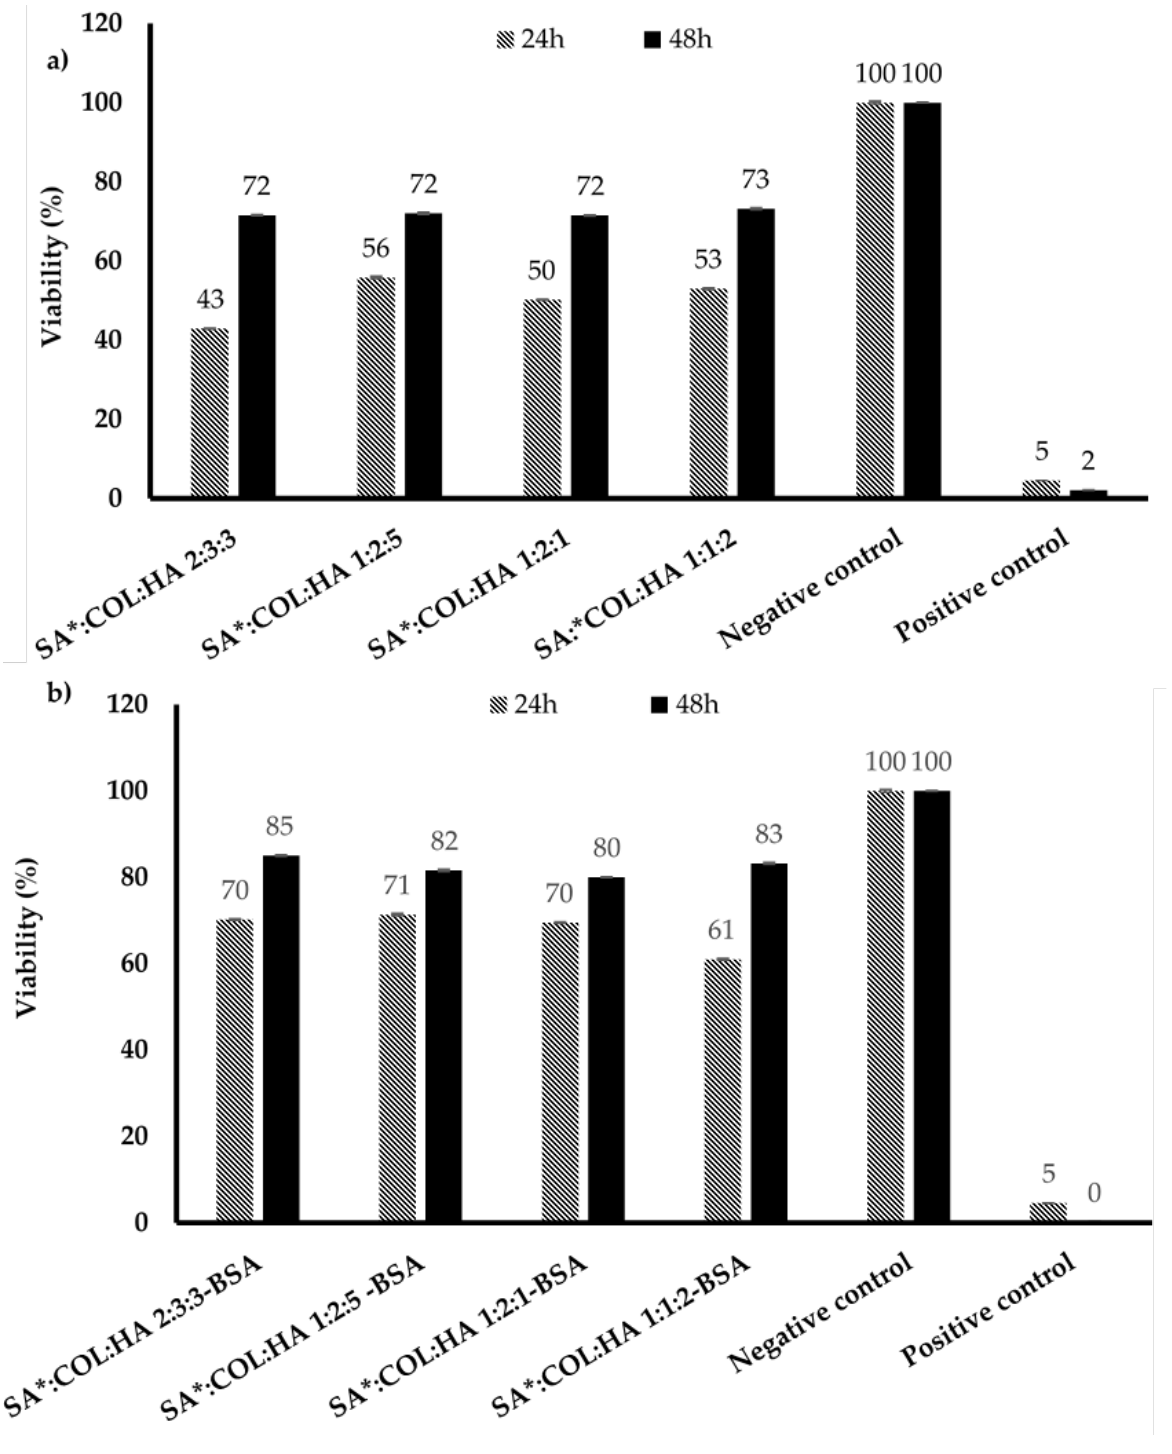
Figure 10. Cell viability of ( a ) primary KCs after exposure to the SA*COL:HA blank scaffolds for 24 and 48 h (mean ± SD n = 9); ( b ) primary KCs after exposure to the BSA loaded SA*COL:HA scaffolds for 24 and 48 h (mean ± SD, n = 9).